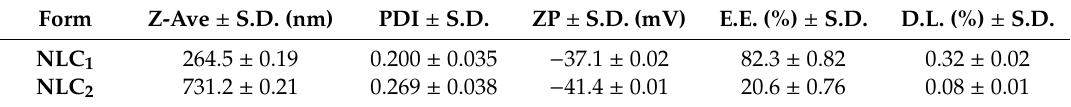
Table 1. Mean particle size (Z-Ave), polydispersity index (PDI), zeta potential (ZP), encapsulation efficiency (E.E. %), and drug loading (D.L. %) of NLC 1 and NLC 2 . Values are the mean of at least three measures.